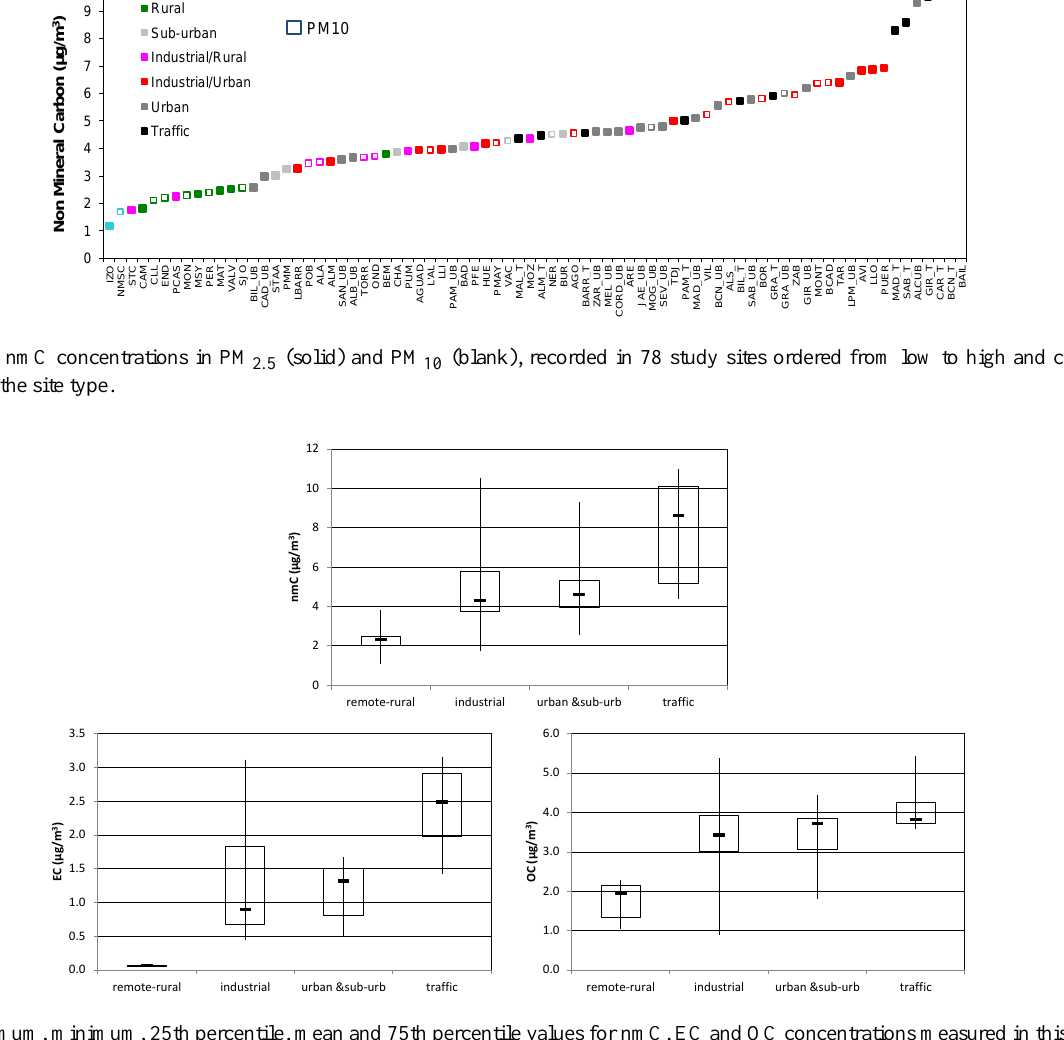
Fig. 3. Maximum, minimum, 25th percentile, mean and 75th percentile values for nmC, EC and OC concentrations measured in this study.